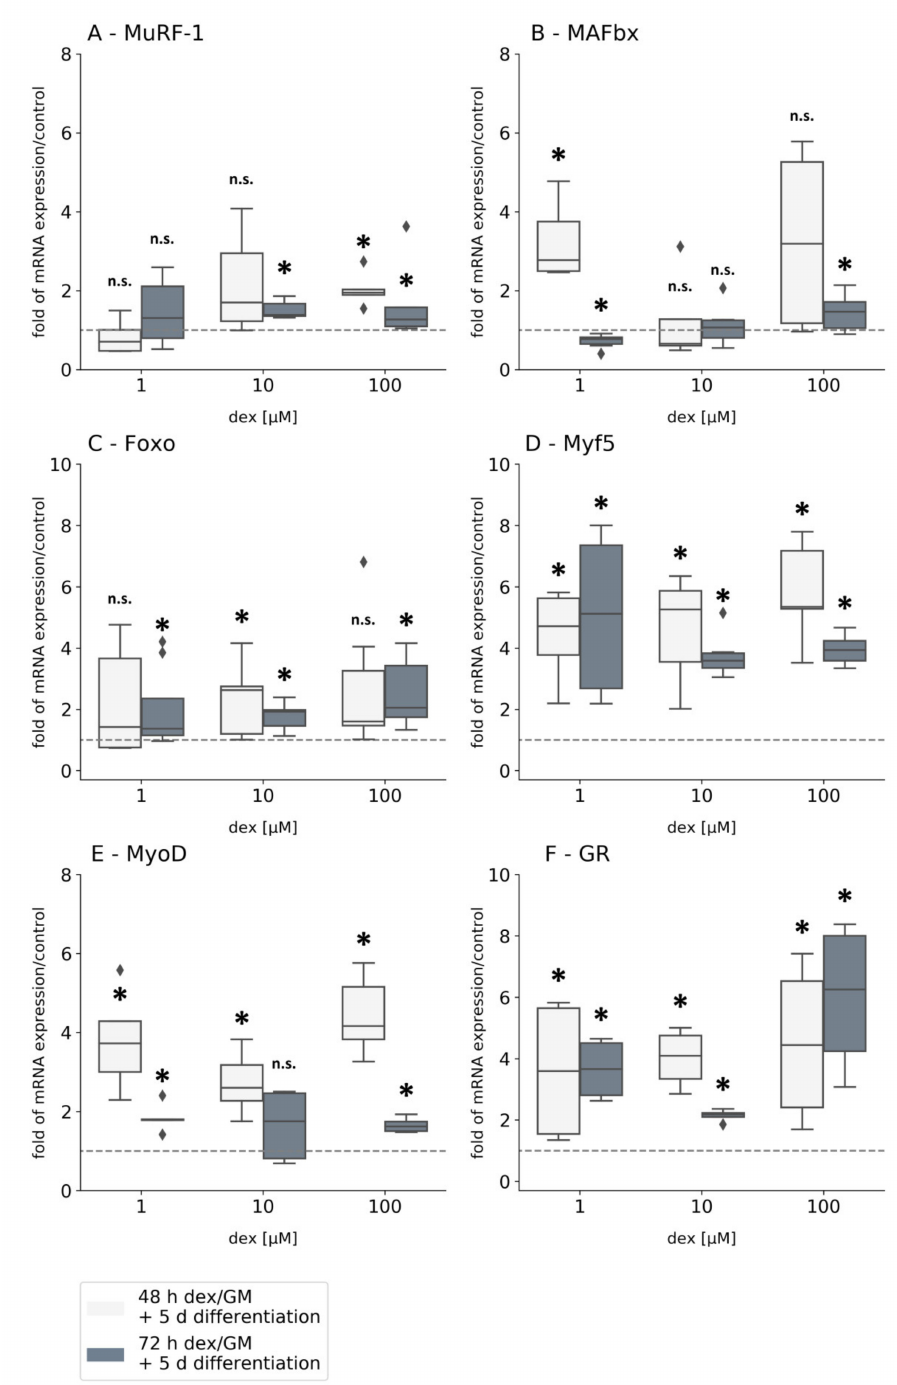
Figure 5. Gene expression analysis of MuRF-1 ( A ), MAFbx ( B ), Foxo ( C ), Myf5 ( D ), MyoD ( E ), and GR ( F ) in primary human myoblasts after dex treatment. The mRNA levels were normalized to GAPDH and calculated as ratios in relation to the untreated control group (interrupted line). Experiments were performed in triplicates with myoblasts isolated from three di ff erent specimens ( n = 9). Results are presented as medians and quartiles, and p values < 0.05 indicate statistical significance (* p < 0.05), and p values > 0.05 indicate no statistical significance (n.s. > 0.05). Rhombs are presented as